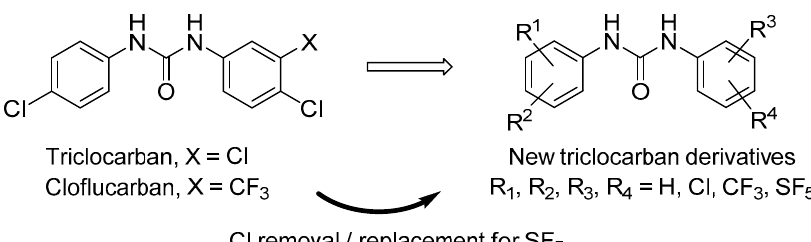
Figure 1. Chemical structures of triclocarban, cloflucarban, and general structure of the new N,N ′ -diarylureas presented in this